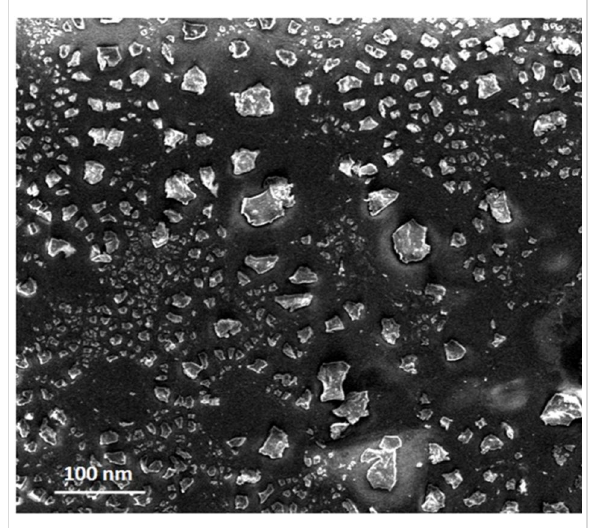
hydrophobic surfaces point toward the solvent and render colloidal stability and uniformity of the particles in organic solvents [23]. The TOPO coated particles suspended in chloro- form were precipitated by adding excess methanol followed by centrifuging at 2000 rpm and re-dispersed in chloroform. A TEM image of the so obtained particles is shown in Figure 5.